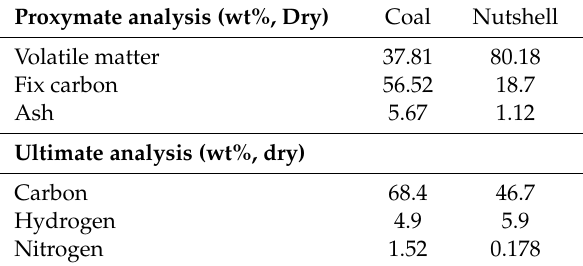
Table 1. Proxymate and ultimate analysis of the used nutshell particles.